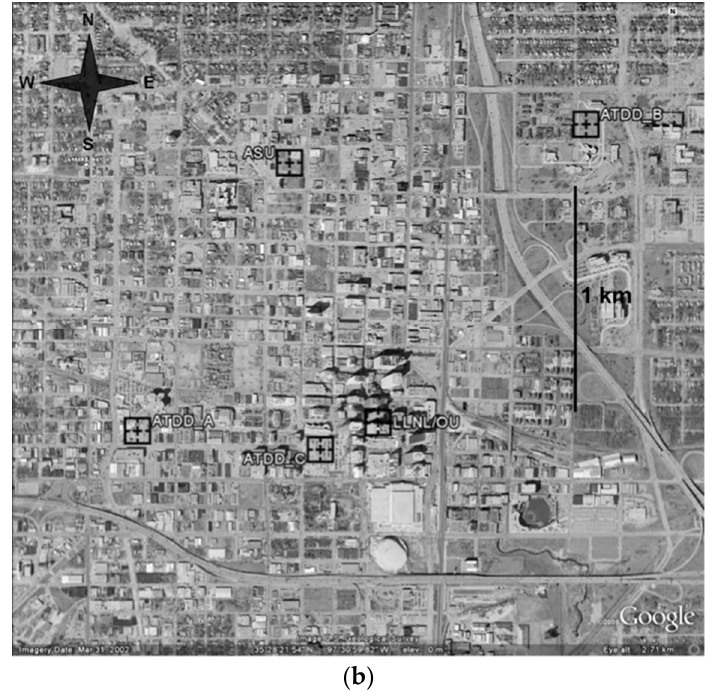
Figure 1. ( a ) Overview of the PNNL Meteorological Station and HOBO locations. The light green pentagons are HOBOs, while the dark green pentagons are meteorological stations (33, ©Courtesy of Battelle memorial Institute. From the Pacific Northwest National Laboratory for the U.S. Department of Energy; ( b ) Overview of the Atmospheric Turbulence and Diffusion Division (ATDD) flux site locations (Hanna 2011, personal communication). These maps cover Oklahoma City.